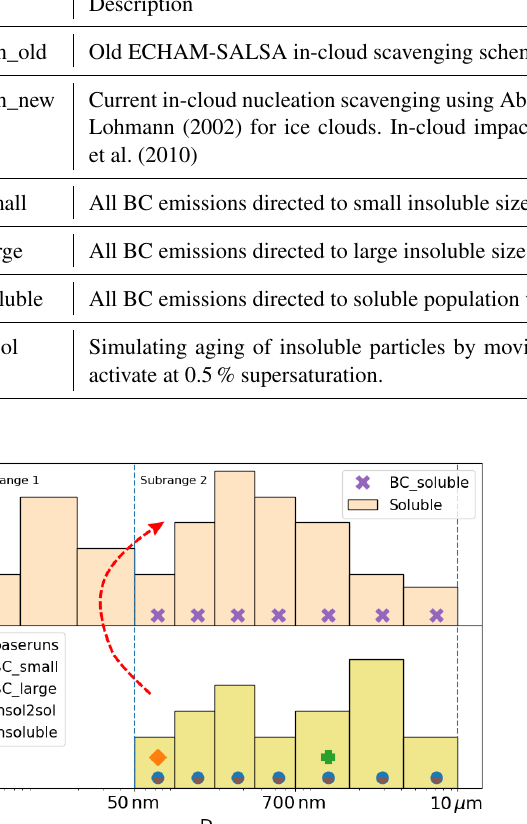
Table 1. Overview of the simulations used in this study. Setup